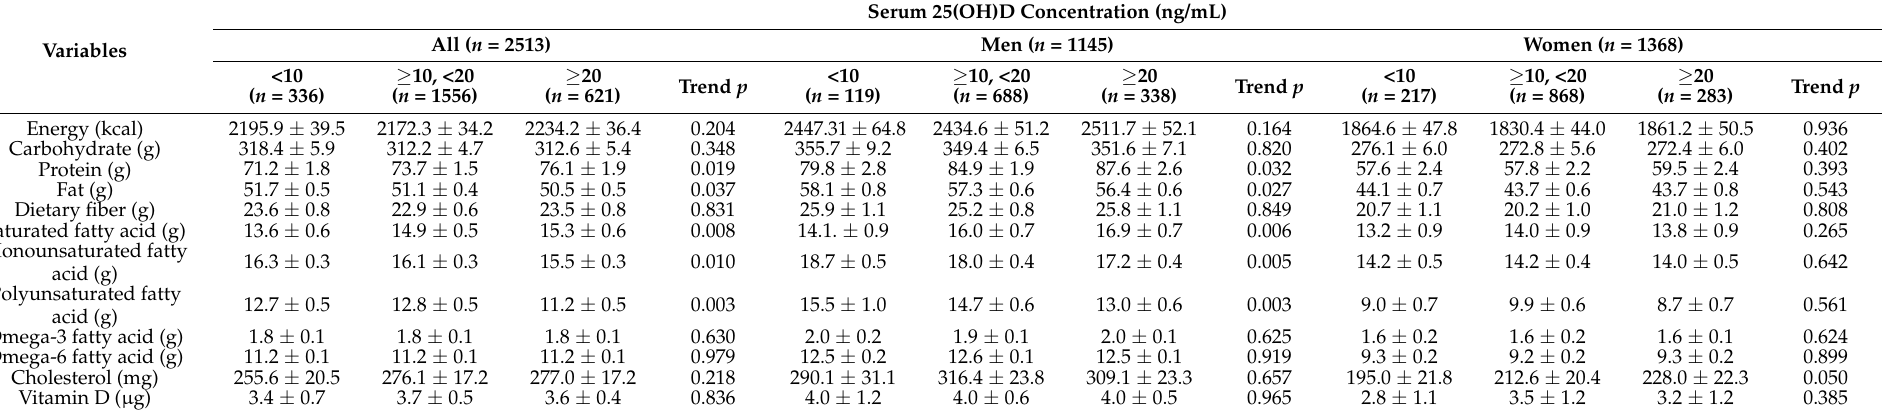
Table 2. Daily nutrient intake of the participants by categories of serum 25-hydroxyvitamin D (25(OH)D) concentration and